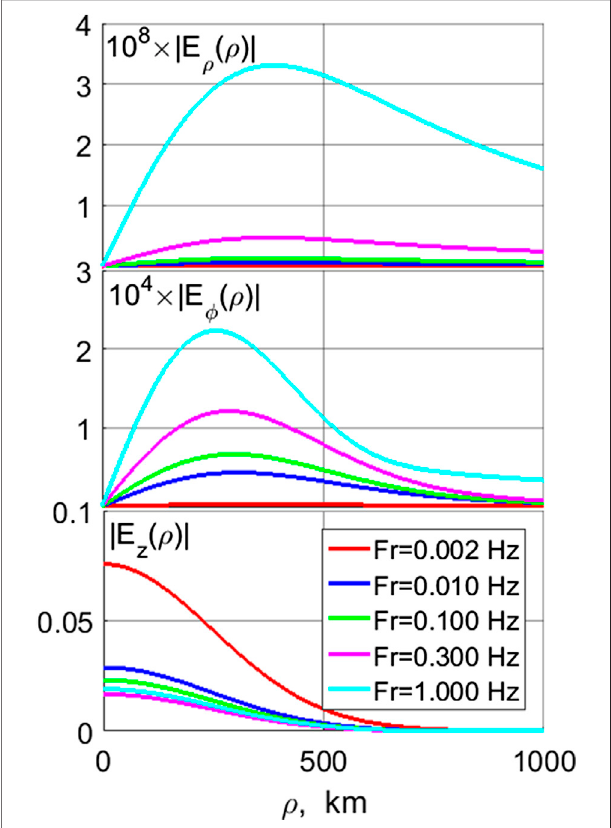
FIGURE 5 | The radial distribution on the ground of the electric componentamplitudes, E ρ ( ρ ), E ϕ ( ρ ),and E z ( ρ )(inV/m),forvariousfrequencies (shown in